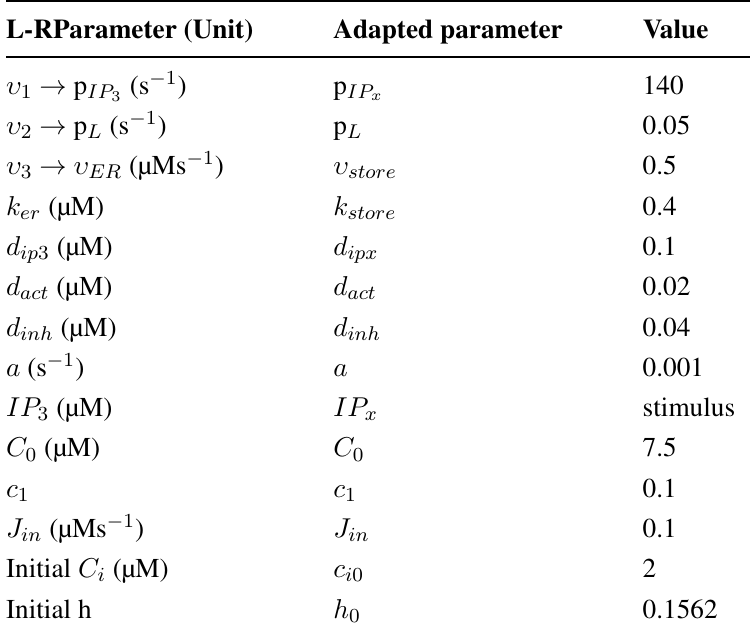
Table 1. List of parameters for the Li and Rinzel model (left), the adapted parameters for the Ca 2+ simulations in a plant system induced by Ch5 (middle) and the used values for the simulations in arbitrary units